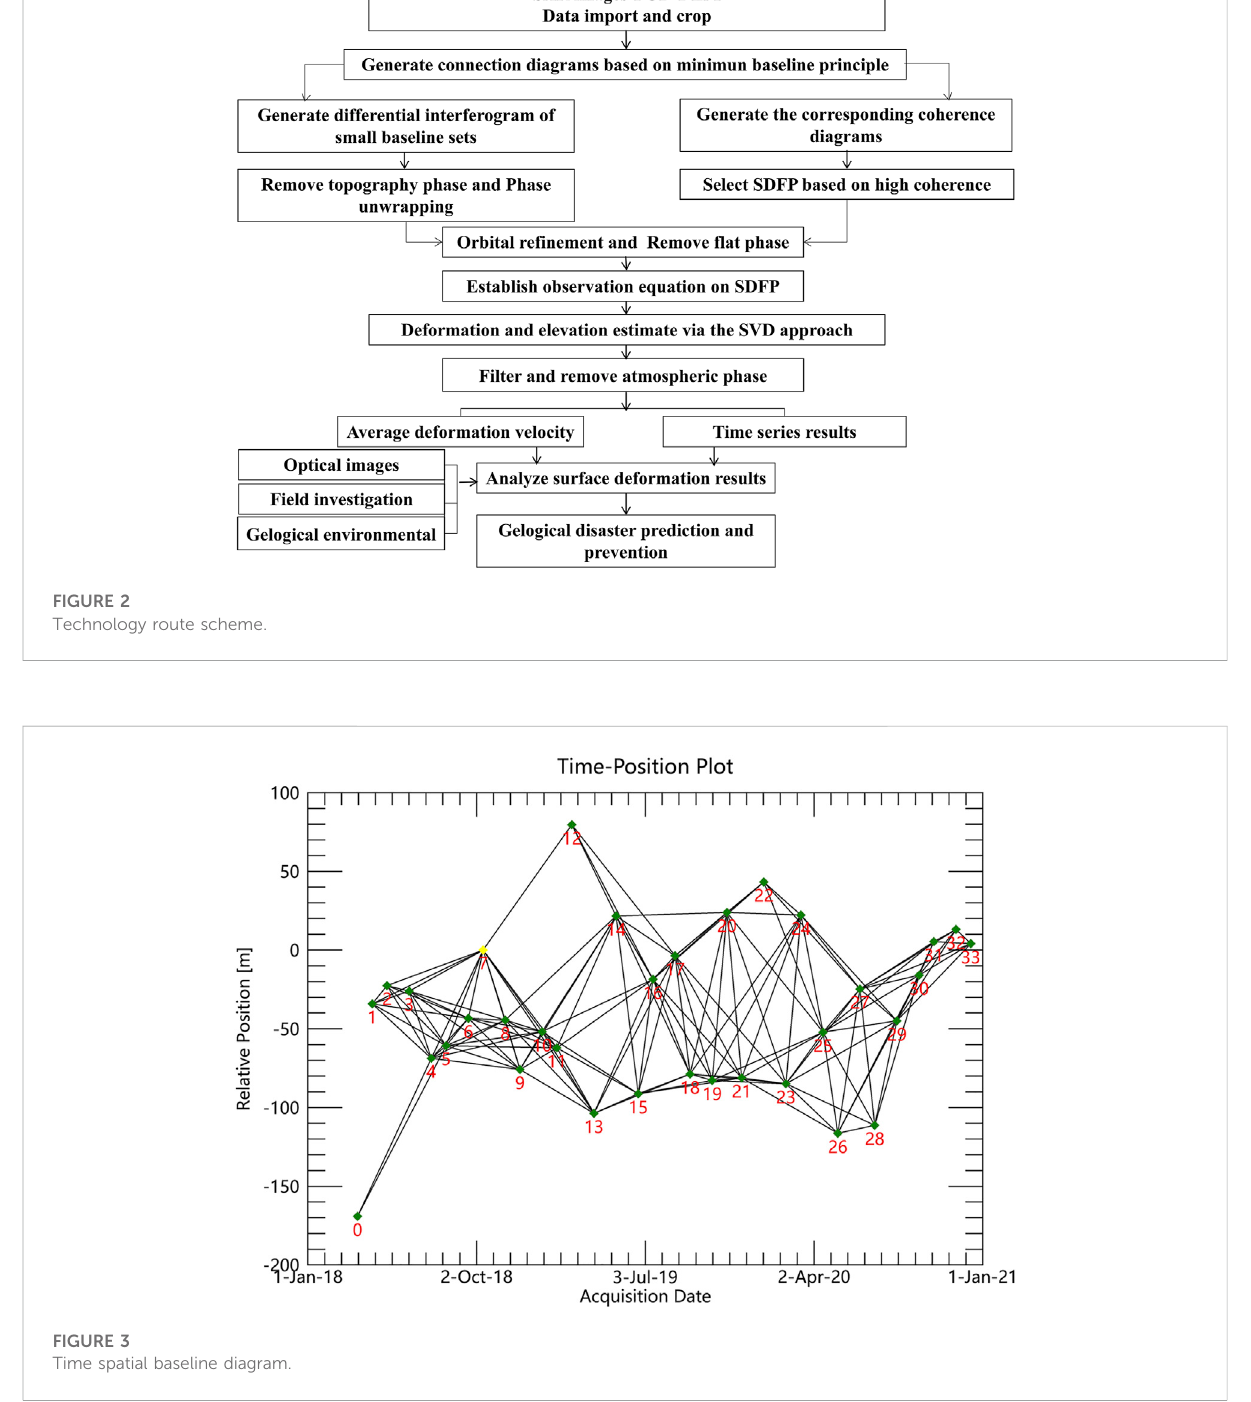
images were, respectively registered and resampled to obtain a small baseline set. SRTM DEM data were used to remove the fl at phase, and the wrapped interference phase was unwrapped. The